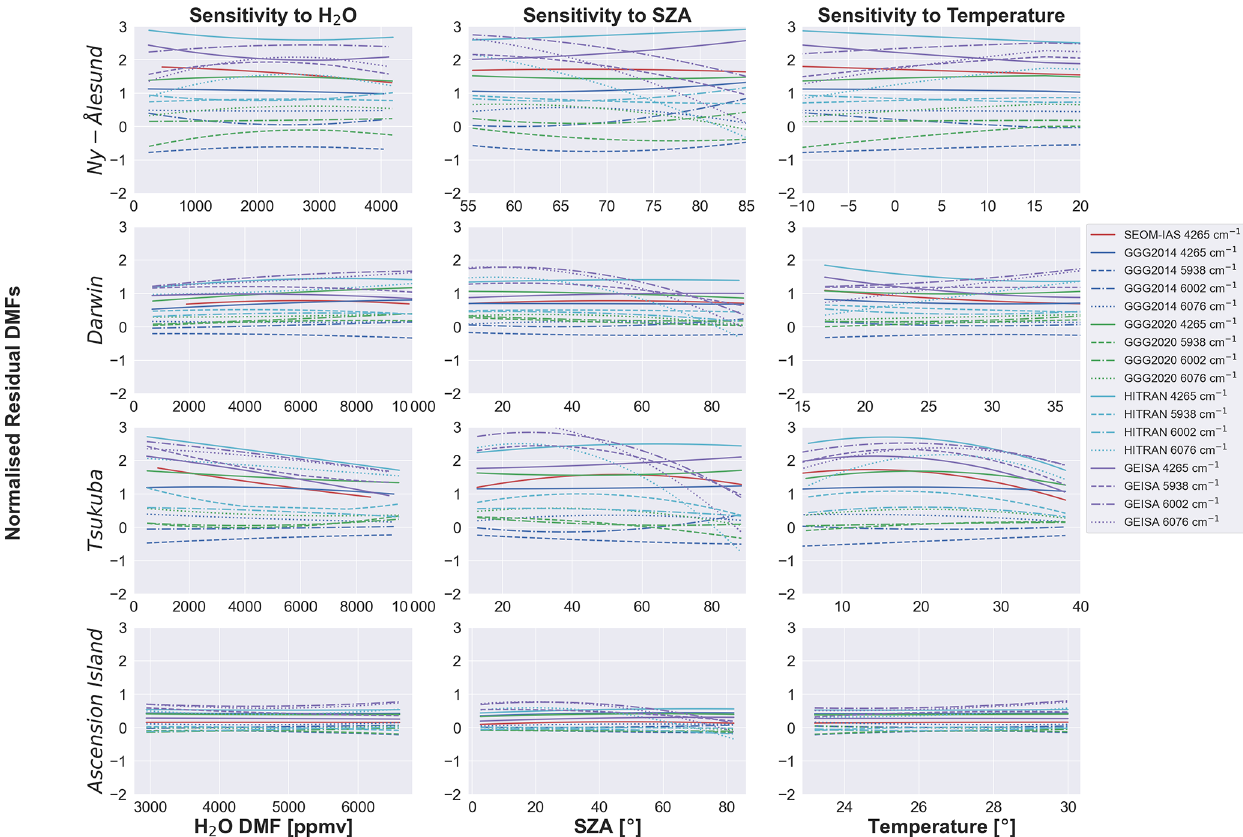
Figure 9. The sensitivity of water vapour, SZA and temperature variations in retrieved 12 CH 4 DMFs from each TCCON site, spectroscopic database and window. Each subplot shows the second-order regression fit of the normalised residual between the retrieved window and spectroscopic database DMFs and the TCCON reference DMFs, with the fit window and spectroscopic database indicated by the legend. Each row of the figure shows data from each TCCON site as indicated in the y axis, and each column shows the sensitivity to a specific condition as shown in the